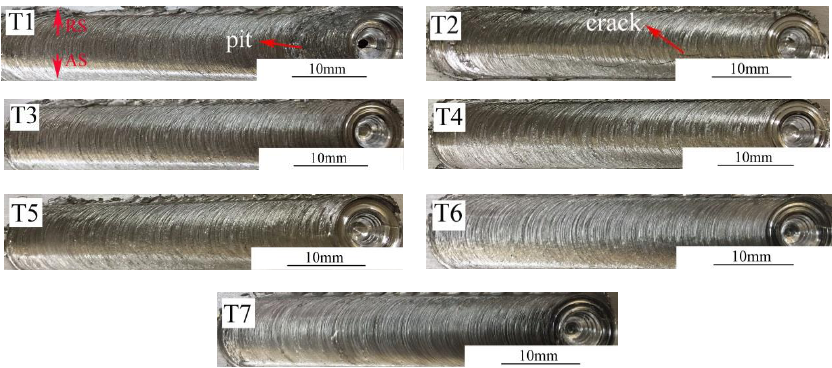
Figure 2. Surface morphology of the welds at different tool offset.